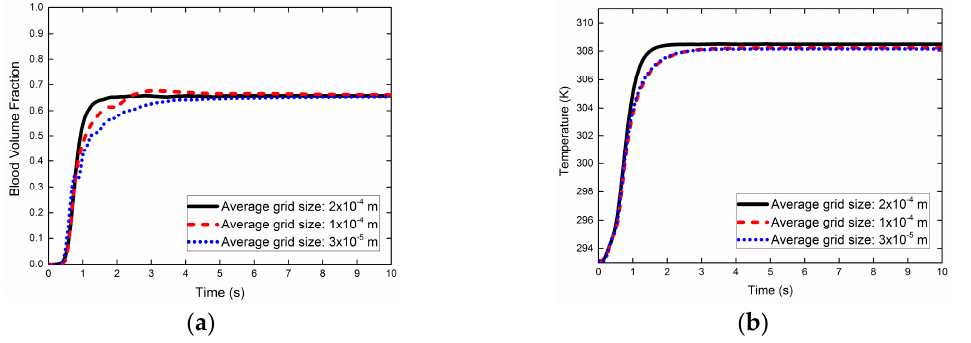
Figure 3. Grid sensitivity analysis (GSA) for: ( a ) blood volume fraction exiting the outlet boundary of the mixing chamber; and ( b ) temperature of the outlet nozzle for chosen average grid sizes of 2 × 10 − 4 , 1 × 10 − 4 and 3 × 10 − 5 m.